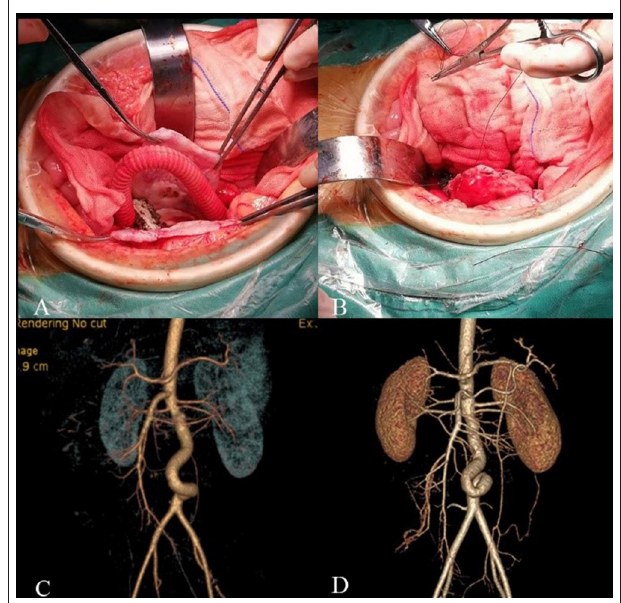
FIGURE 2 | Intraoperative and follow-up images. (A) A 10mm Dacron aorto-aortic tube graft replace the AAA with a “C” shape. (B) The aneurysmal sac was wrapped around the graft. (C) CTA 7 days after surgery. (D) CTA 40 months after surgery showed twisted but unobstructed